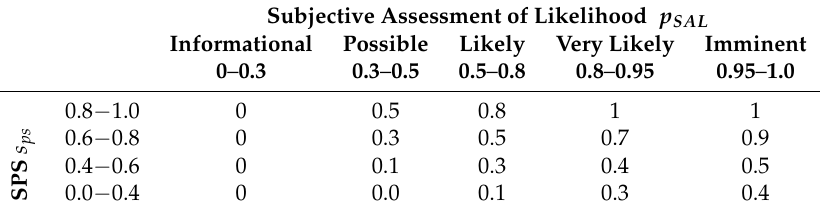
Table 3. Risk assessment table L ( s ps , p SAL ) .